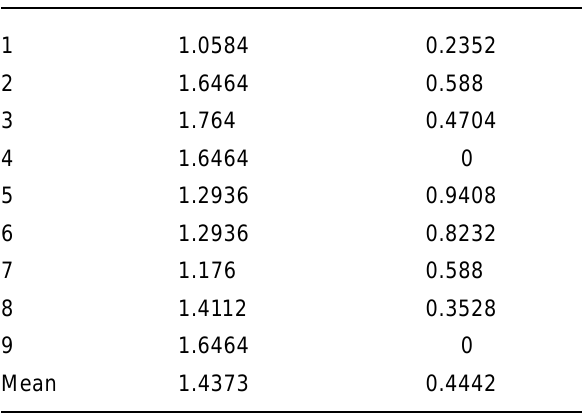
TABLE 5- Statistical data for the disrupted-reinstrumented-